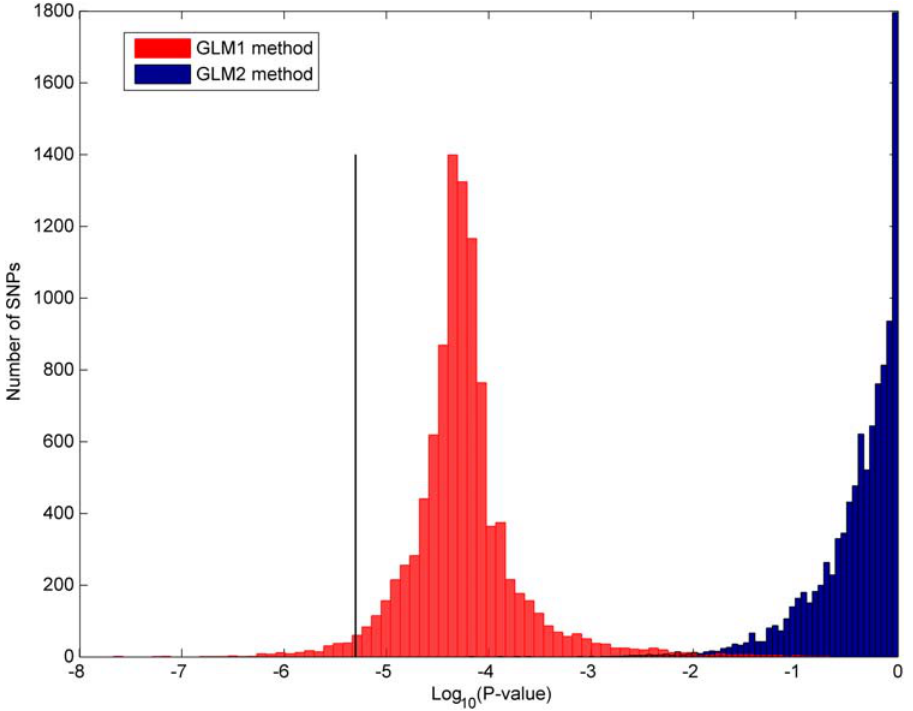
Figure 2. Distribution of p-values computed by GLM1 and GLM2 SNP selection methods. The figure is shown in logarithmic scale for convenience. The vertical line is the Bonferroni adjusted a -level (0.05/10,009). While there are SNPs that are significant according to GLM1 method, no SNP is significant by GLM2. The distribution of p-values for GLM2 is uniform, however the distribution for GLM1 is not.